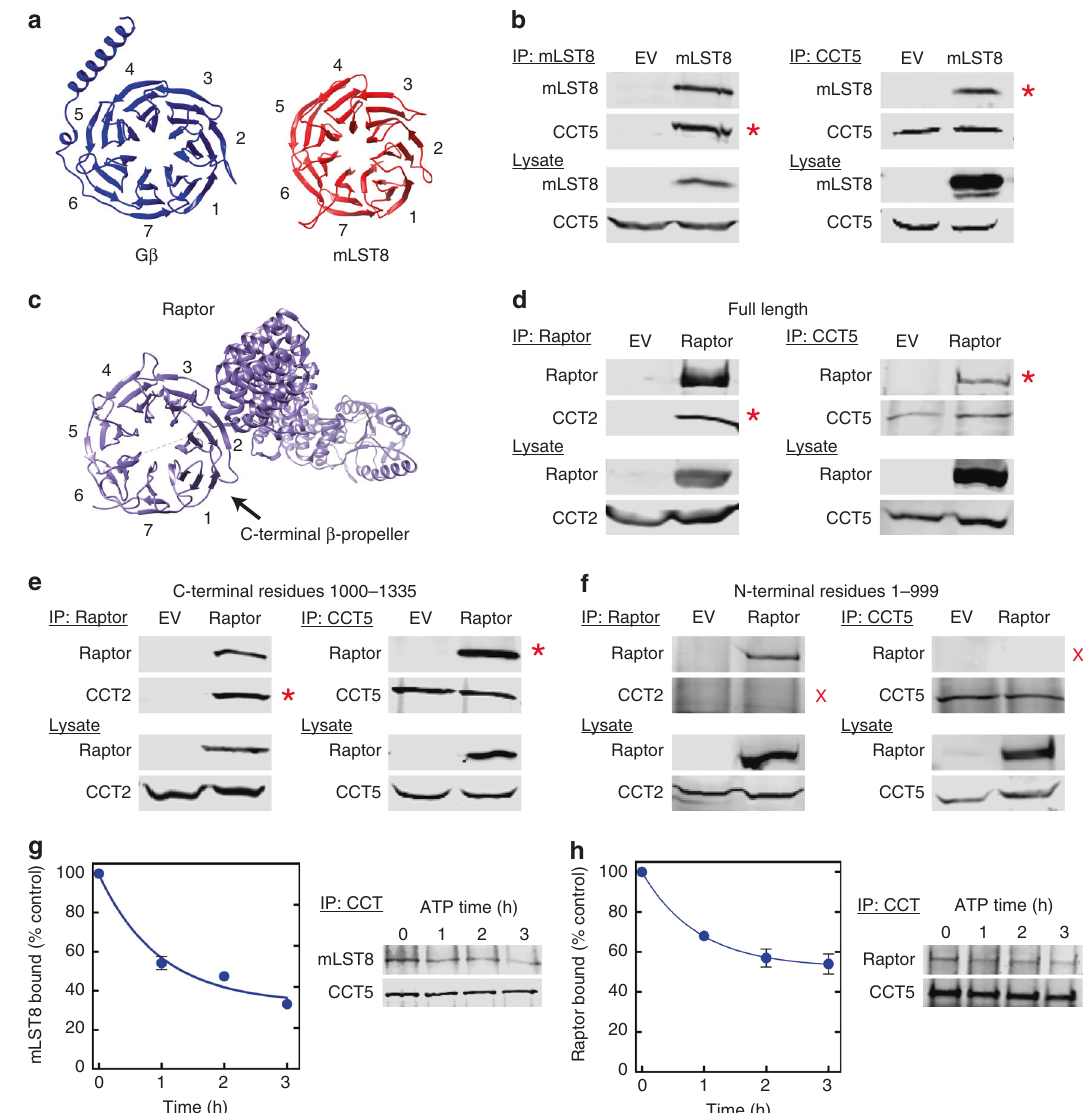
Fig. 1 mLST8 and Raptor bind CCT. a β -propeller structures of G β (PDB 1TBG) and mLST8 (PDB 4JT6). The β -sheets are numbered according to convention with blade 7 containing β -strands from both the N- and C-termini. b Co-immunoprecipitation of mLST8 and CCT. HEK-293T cells were transfected with mLST8 or an empty vector (EV), immunoprecipitated, and immunoblotted as indicated. Co-immunoprecipitating bands are marked (red asterisks). c Raptor structure (PDB 5EF5) with β -sheets numbered as in panel ( a ). d – f Co-immunoprecipitation of Raptor and CCT. Cells were transfected with full length HA-tagged Raptor ( d ), or HA-tagged constructs containing the C-terminal β -propeller ( e ) or the N-terminal caspase and armadillo domains ( f ). Control cells were transfected with empty vector as indicated. Cells were immunoprecipitated and immunoblotted as indicated. All blots are representative of at least three separate experiments. g ATP causes release of mLST8 from CCT. CCT immunoprecipitates from cells overexpressing mLST8 were treated with 5 mM ATP for the times indicated, washed and immunoblotted for mLST8 and CCT5. The amount of mLST8 remaining is shown as a percent of the no ATP control. Error bars smaller than the symbols are not visible. h ATP causes release of Raptor from CCT. The CCT immunoprecipitation experiment was repeated with cells overexpressing Raptor. Source data are provided in the Source Data fi